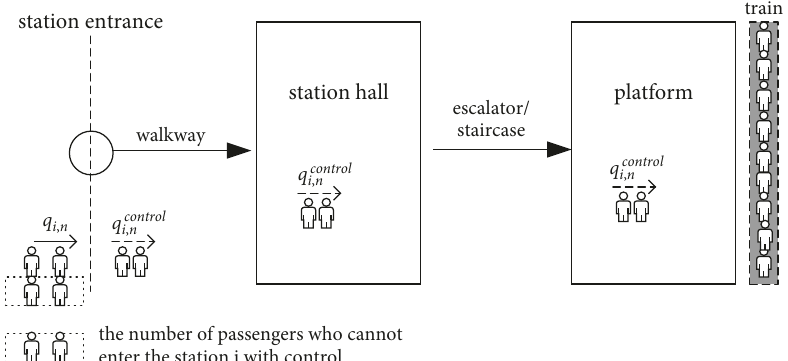
Figure 6: Process of passengers entering a